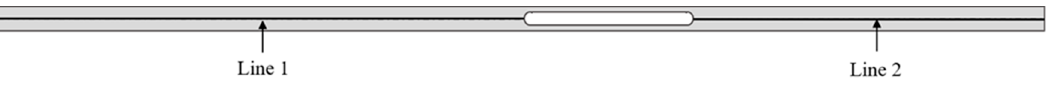
Figure 14. Pressure distributions of line 1 (the axis line in front of the pod) and line 2 (the axis line at the rear of the pod) for t = 0.2–1.0 ( v P = 300 m/s, BR = 0.36, P tube = 101.325 Pa, L pod = 43 m). Pod moves from right to left. Red triangles represent the tube pressure of 101.325 Pa.